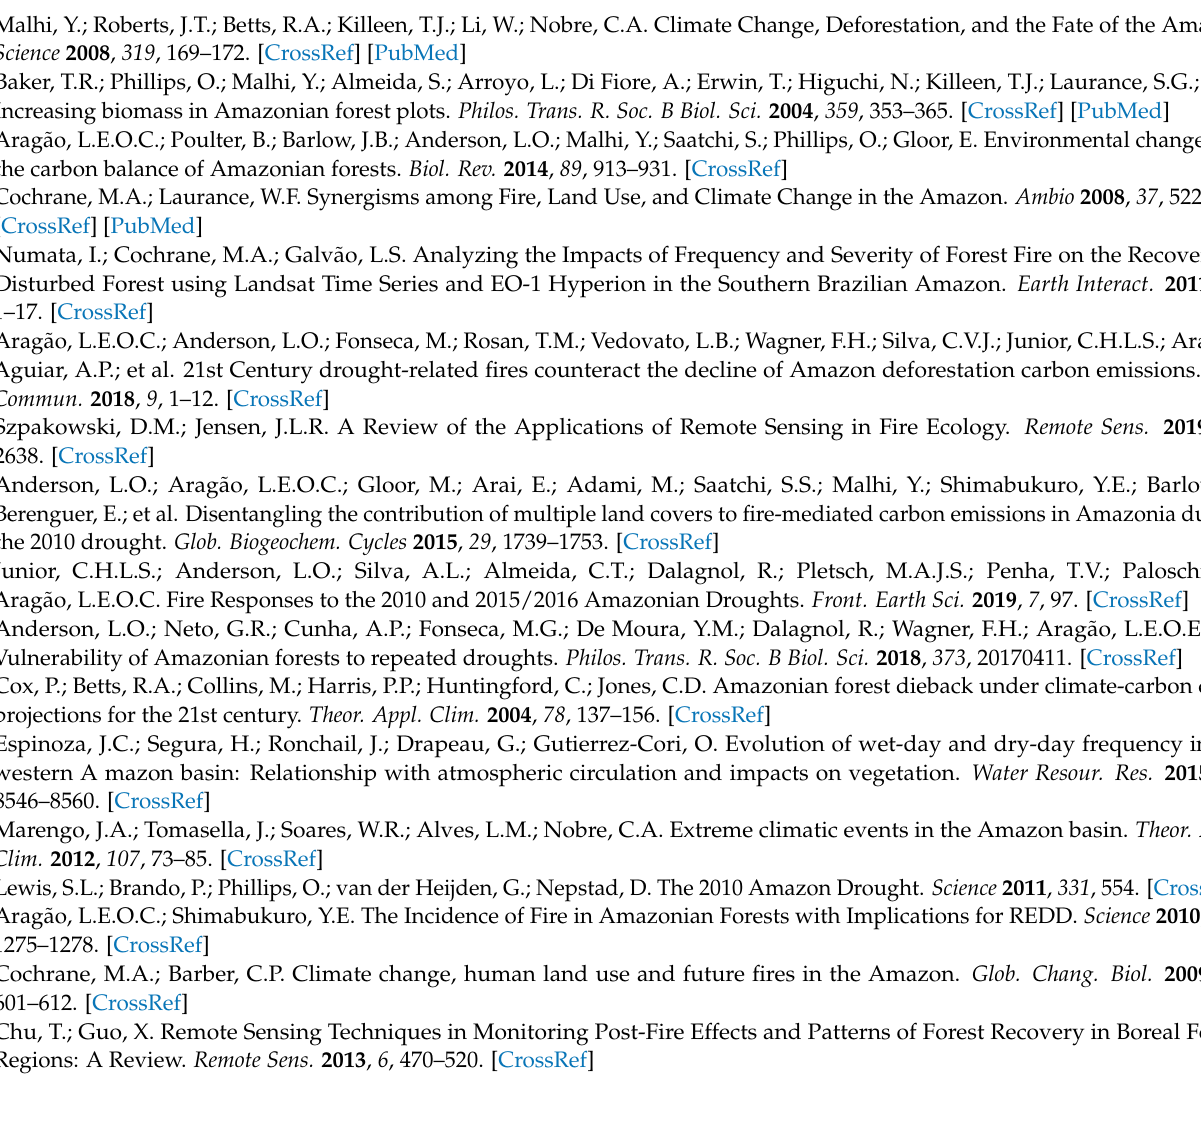
2019, Figure S12: Spatial distribution of cumulative active fires with all confidence levels on 0.1